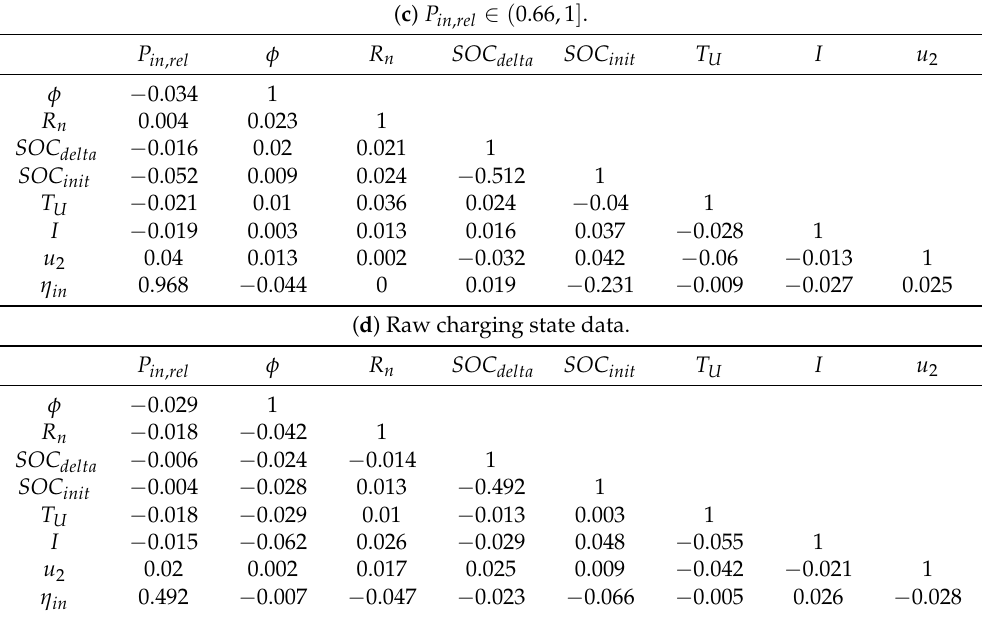
( c ) P in , rel ∈ ( 0.66,1 ]